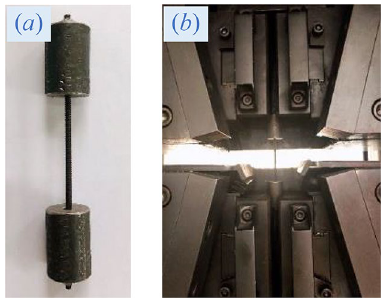
Figure 2. Mechanical property test of experimental bolt: ( a ) experimental bolt and pattern die, ( b ) detail of bolt drawing test.